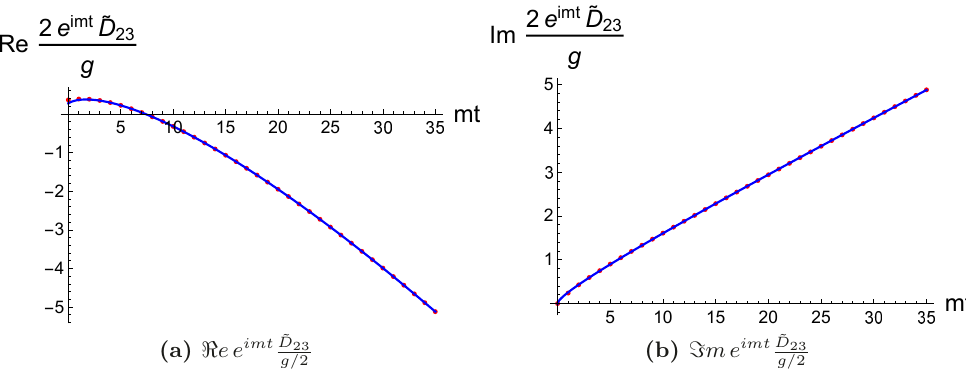
Figure 7. Real and imaginary parts of e imt ˜ D 23 for time instants mt = 0 , 1 , 2 . . . , 35 for a quench g/ 2 in the Ising model. The red dots correspond to system sizes mL = 70 and the blue curve to to the fitted curves of type a + b √ mt + c mt + d mt ln mt and a + b √ mt + c mt . g =